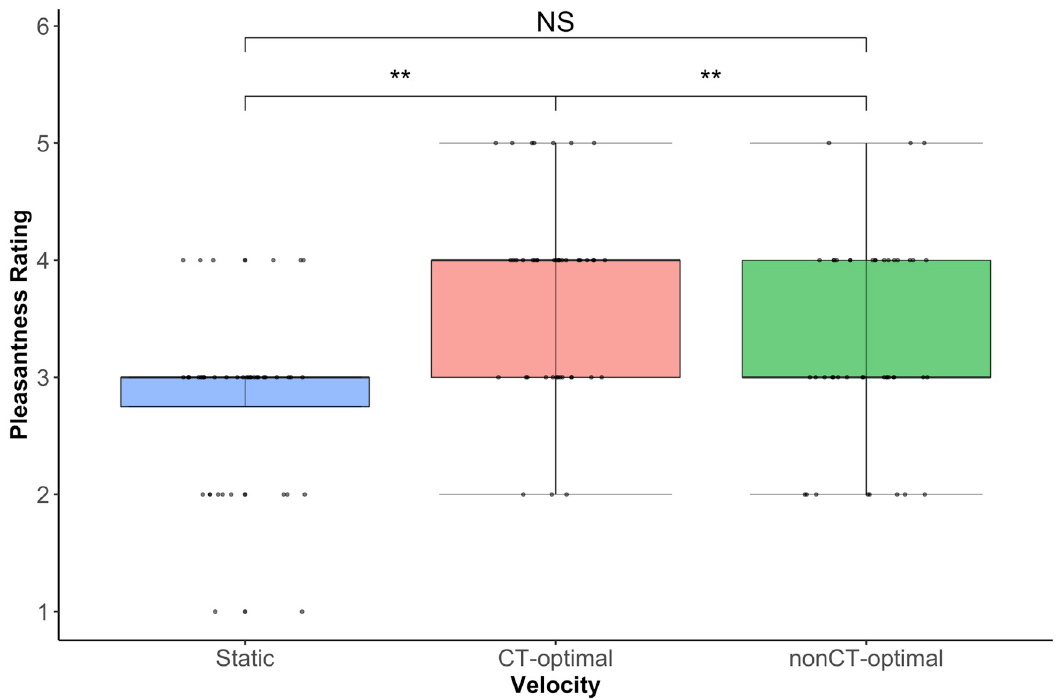
Fig 2. Box and whisker plot showing median pleasantness ratings (thick black line) for touch at the 3 stroking velocities for question 1. Dots represent individual participant ratings. There is a significant main effect of velocity (p < 0.001), but no effect of location, or location x velocity interaction. Wilcoxon Signed Ranks tests confirmed that the CT optimal velocity, slow stroking touch was rated significantly more positively than either static or fast stroking, non-CT optimal velocity touch, �� ps < 0.002.